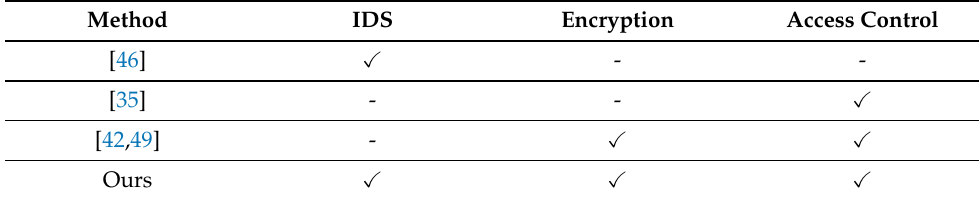
Table 3. Comparisons with existing